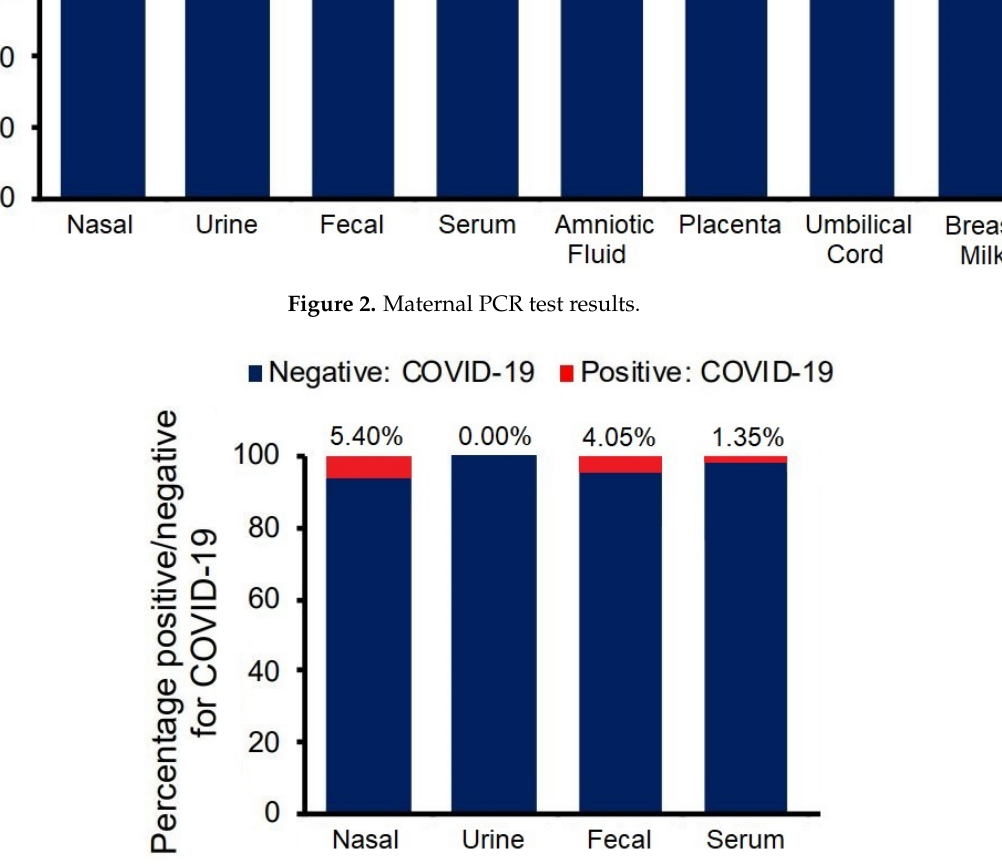
Figure 3. Neonatal PCR test results.